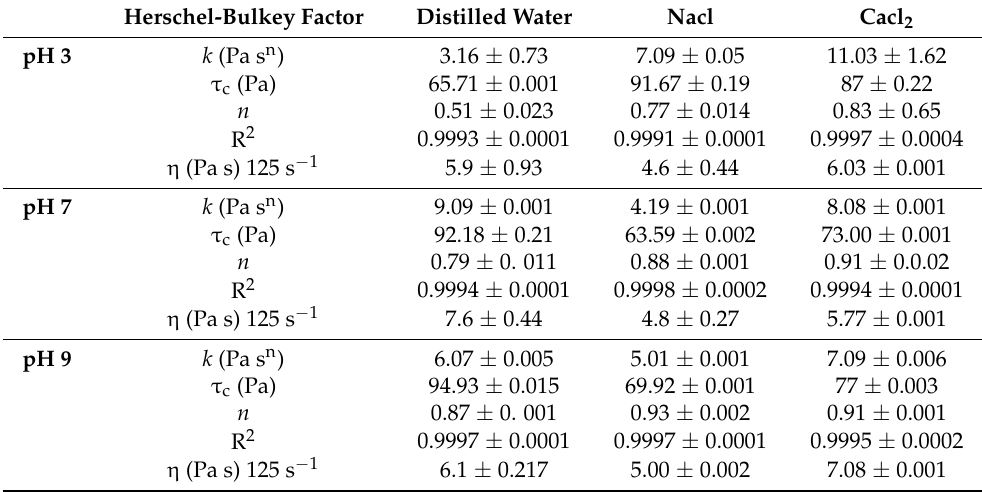
Table 1. Modeling of the flow curves between 10 and 600 s − 1 of shear stress of API emulsions at pH 3, 7 and 9 with and without NaCl and CaCl 2 . Herschel-Bulkey Factor Distilled Water